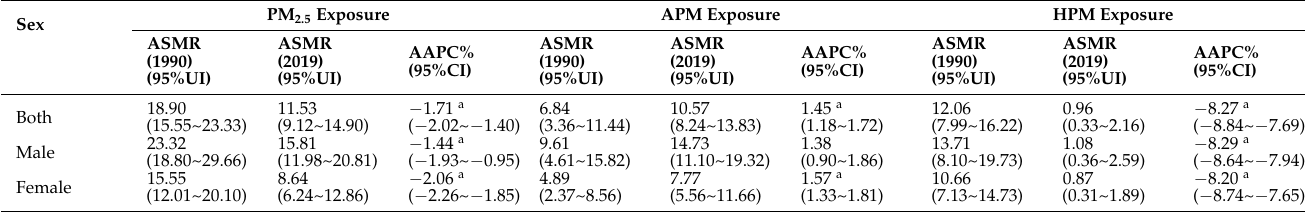
Table 1. Age-standardized mortality rate per 100,000 of IHD attributable to PM 2.5 exposure (APM and HPM) in 1990 and 2019, and its temporal trends from 1990 to